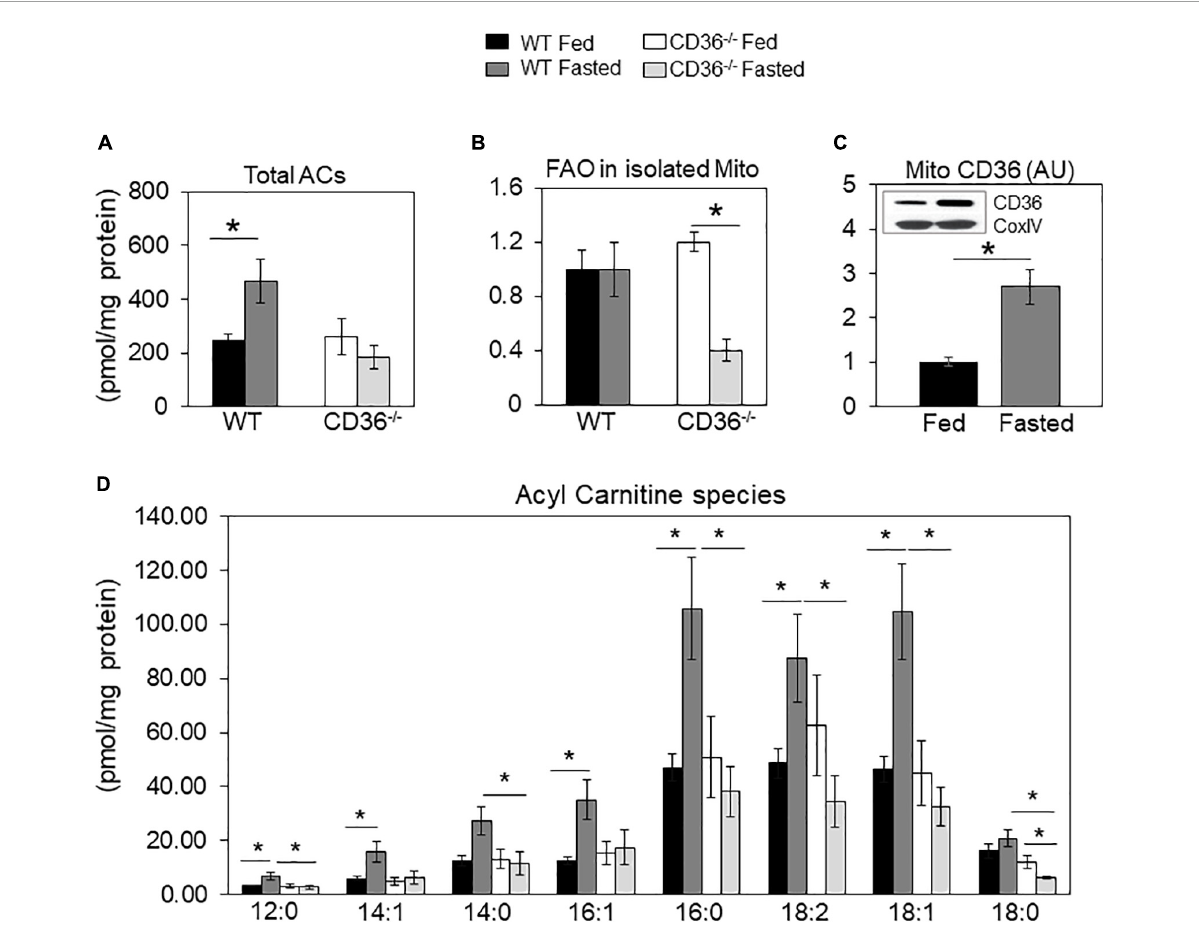
FIGURE2 Acylcarnitines and fatty acid oxidation (FAO) of mitochondria isolated from fed and fasted WT and CD36 − / − hearts. (A) Levels of total acylcarnitines (ACs). (B) Mitochondria were isolated to measure CD36 content and fatty acid oxidation (FAO) rate determined from CO 2 or 3 H water release from radiolabeled substrates as described in Methods. Data are expressed as ratios of FAO rates from fasted and fed hearts. (C) CD36 expression and densitometry in mitochondrial lysates relative to COX IV expression by western blotting. (A,B) n = 5/group; (C) n = 7/group; (D) n = 3/group. Results are reported as pmol/mg of protein. Data are means ± SE with n representing the number of mice per group, * p <